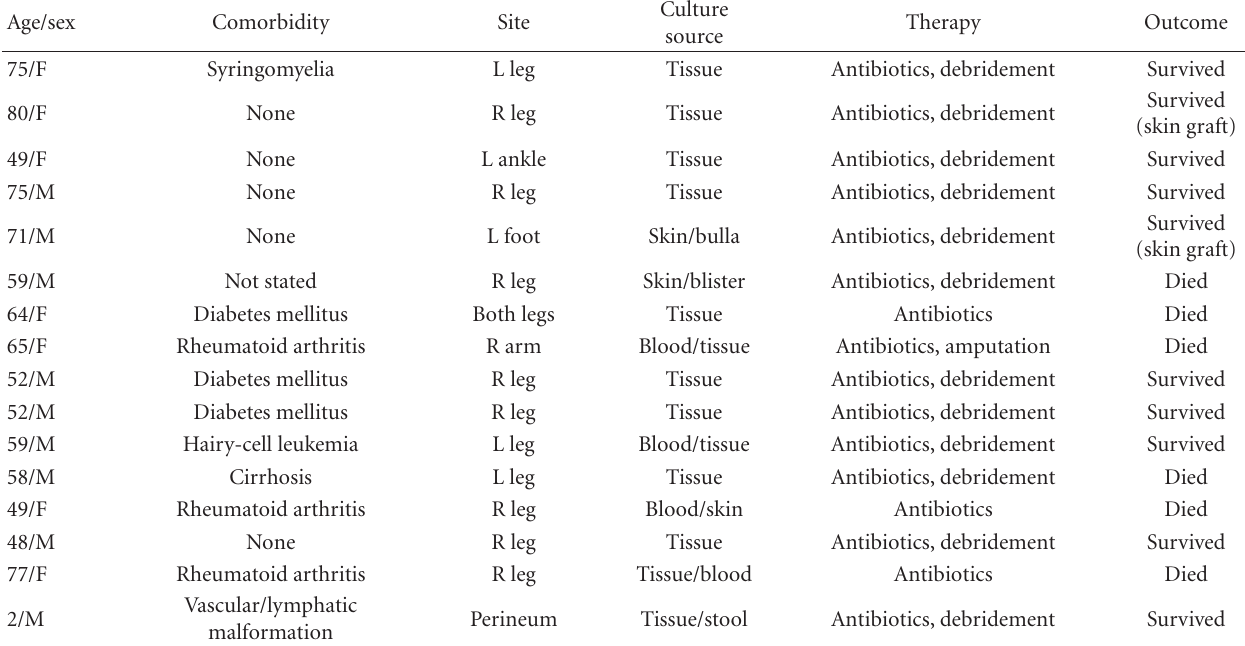
Table 1: Patients with GGS necrotizing fasciitis (taken from [10–13, 17], and current